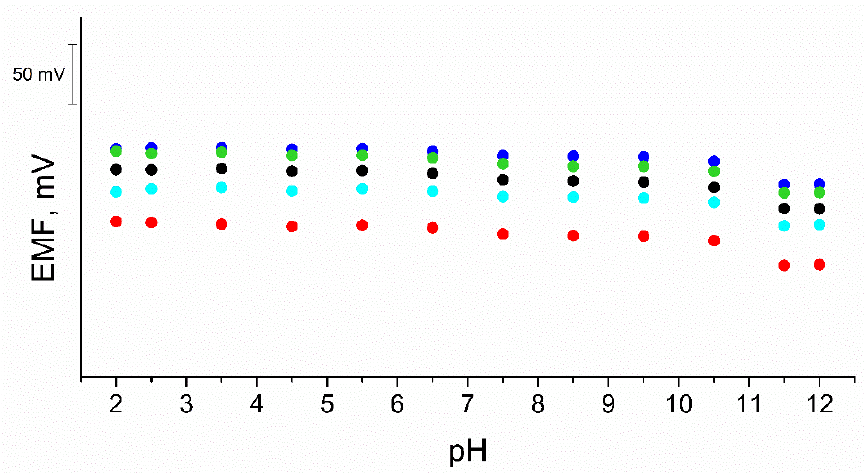
Figure 8. pH sensitivity test of GC/eCNF/K + ‐ ISM (blue), GC/eCNF ‐ Co/K + ‐ ISM (cyan), GC/eCNF/CNT[HD] ‐ Co/K + ‐ ISM (green), GC/eCNF/CNT[HD] ‐ NiCo/K + ‐ ISM (black), GC/eCNF/CNT[LD] ‐ NiCo/K + ‐ ISM (red).